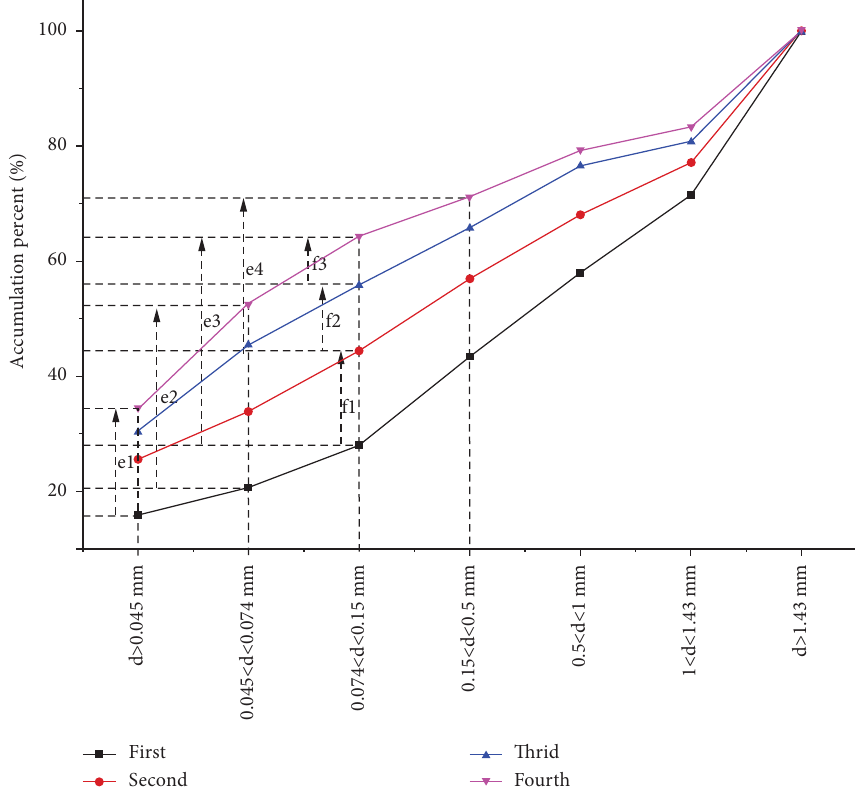
Figure 7: Te cumulative size distribution of the second group of cyclic powdering (diasporic bauxite).